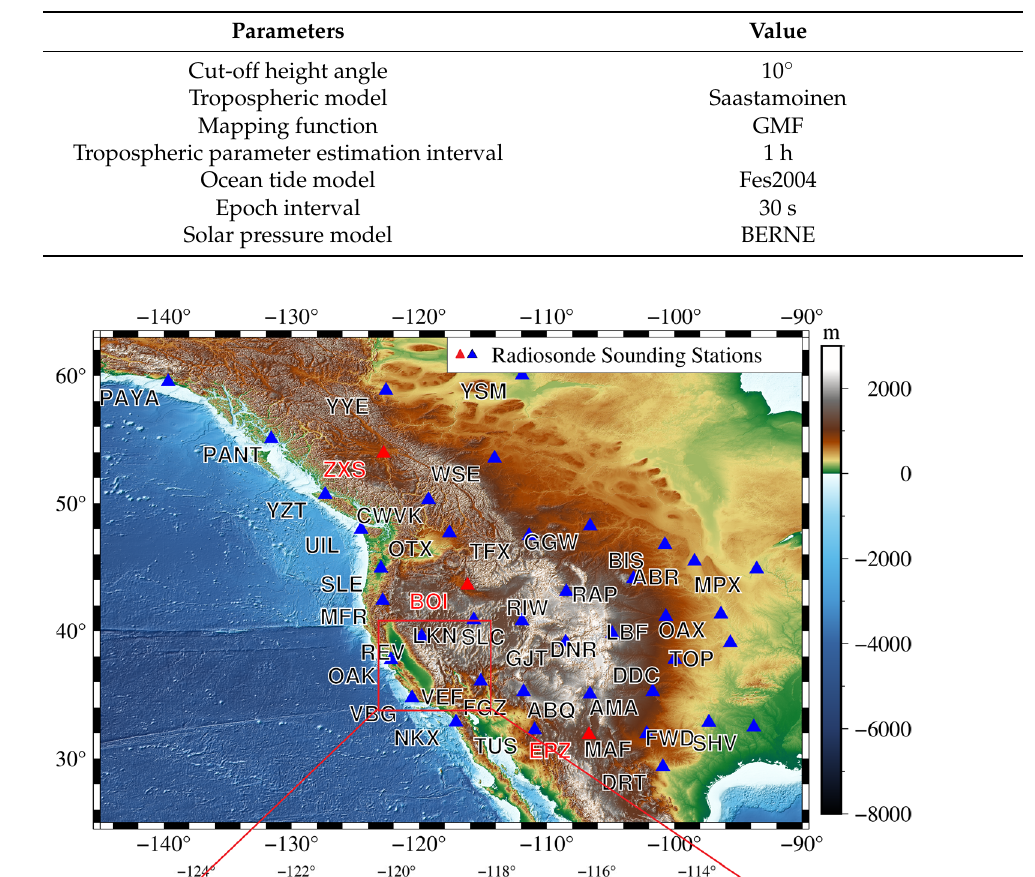
Table 1. The Global Positioning System (GPS) data processing strategy.